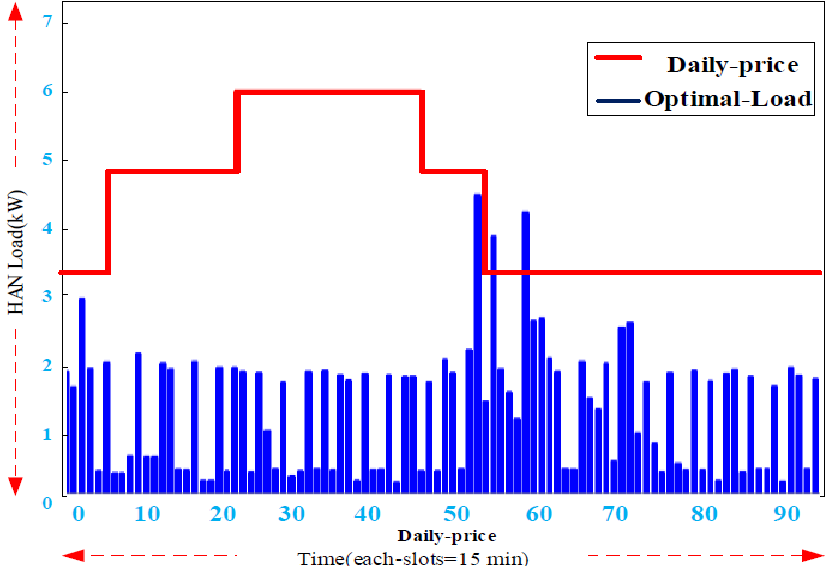
Figure 16. Total HAEMS load after optimization.